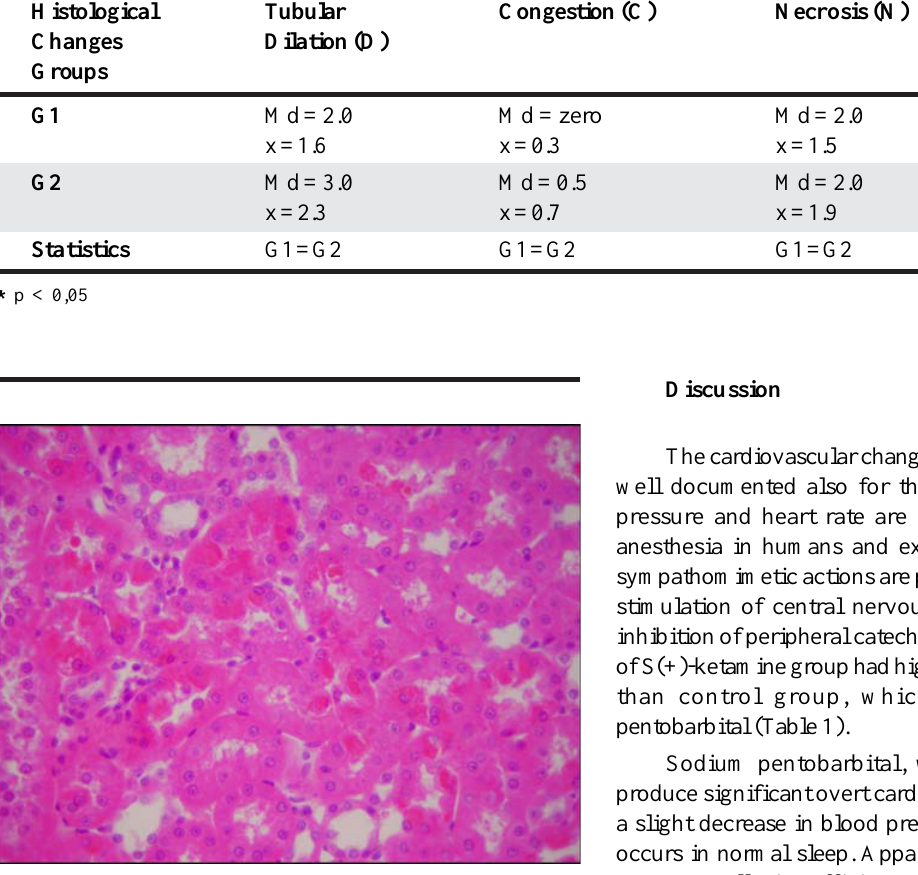
TABLE 2 - Histological changes. Median (Md) and mean (x) values Histological